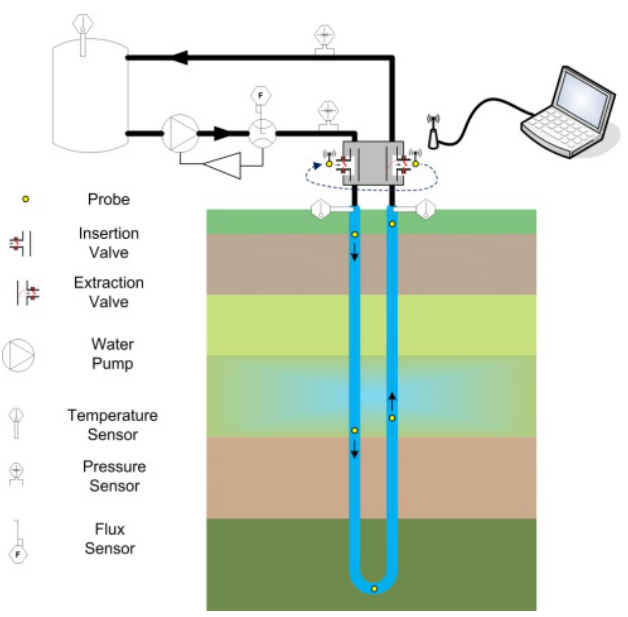
Figure 1. Schematic of BHE and sensor